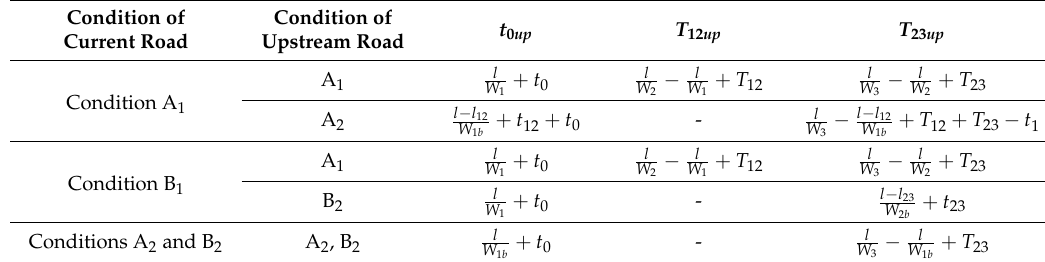
Table 3. Parameters of the upstream road section under each condition of continuous propagation.